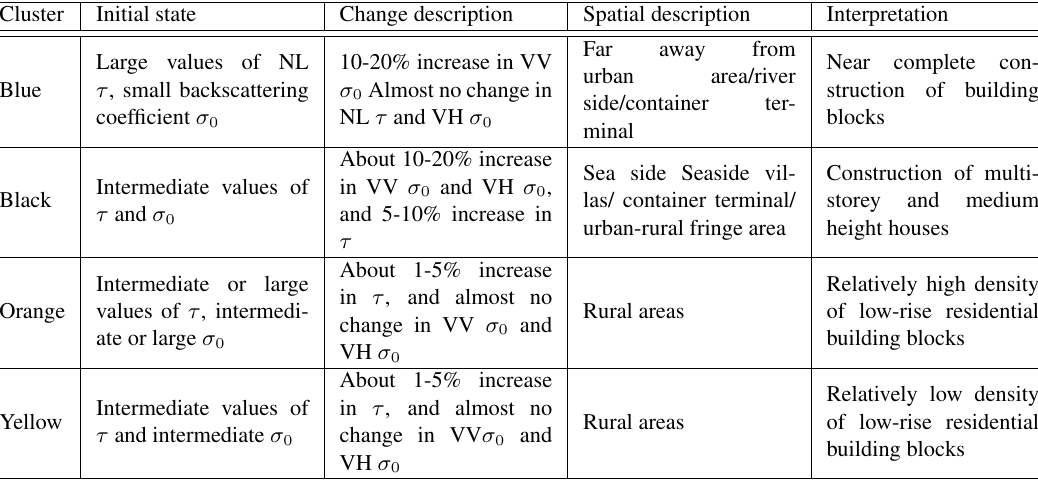
Table 1. Interpretation of change patterns in the Yangtze River Delta